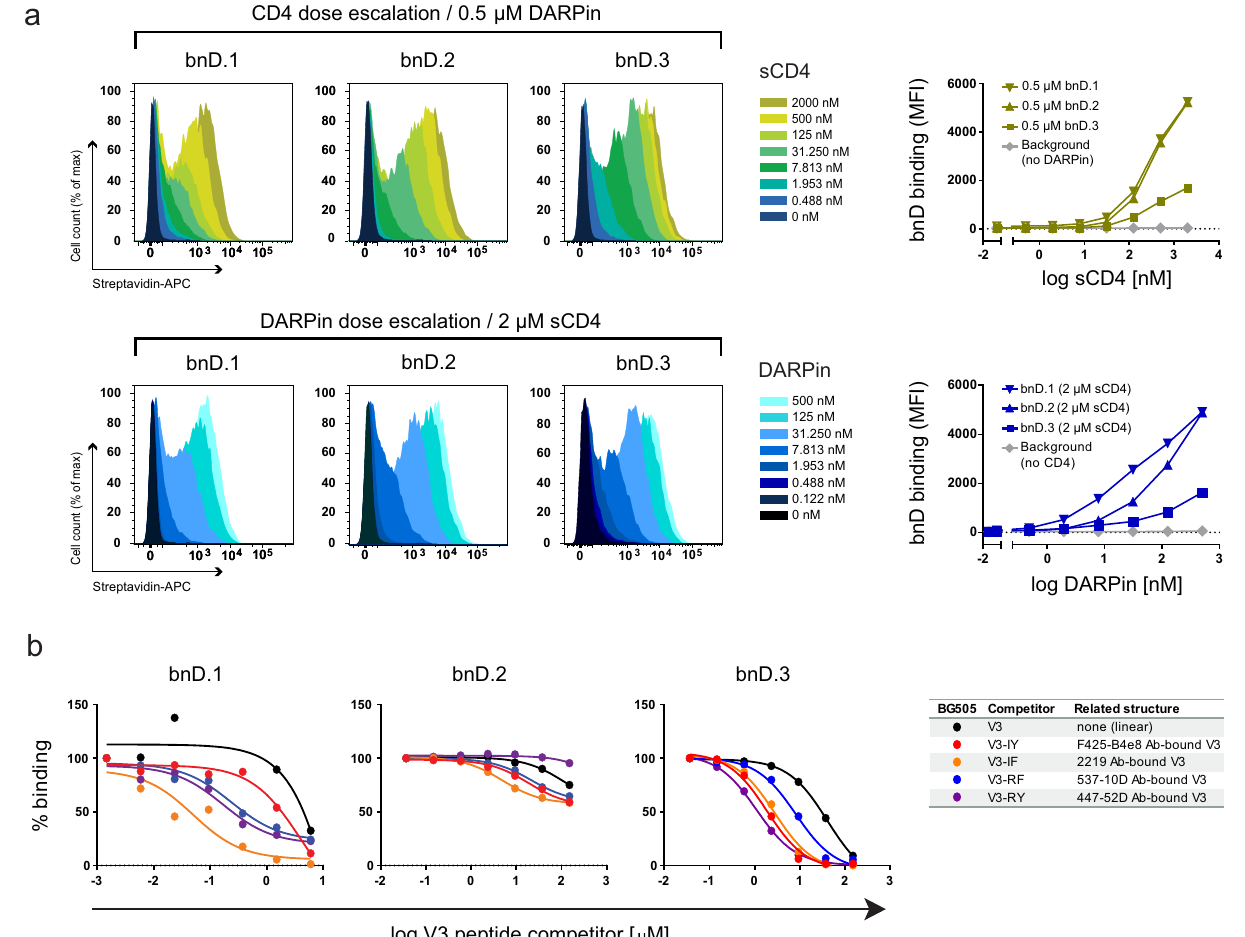
Fig. 2 V3 DARPins depend on CD4 triggering to bind native HIV-1 Env. a Binding of biotinylated DARPins to cells expressing Env (JR-FL) was assessed by fl ow cytometry. Histograms of normalized fl uorescence intensities and corresponding plots showing mean fl uorescence intensities (MFI) as a function of concentration are depicted. Top: DARPin (0.5 µ M) binding in the presence of increasing concentrations of sCD4. Bottom: DARPin binding at increasing concentrations in the presence of 2 µ M sCD4. Background binding was assessed on cells expressing Mulv Env (shown are representative MFI data for the three bnDs). b Competition ELISA to probe for V3-crown conformational preferences of DARPins. DARPin binding to immobilized recombinant Env-derived proteins was measured at a concentration just before reaching saturation. Env proteins were chosen to maximize the dynamic binding range for the individual DARPin (bnD1: BG505gp120 Δ V1V2; bnD.2: JR-FLgp120; bnD.3: trimeric BG505-SOSIP). Each DARPin/Env pair was competed with increasing concentrations of the BG505 V3 peptides indicated in the